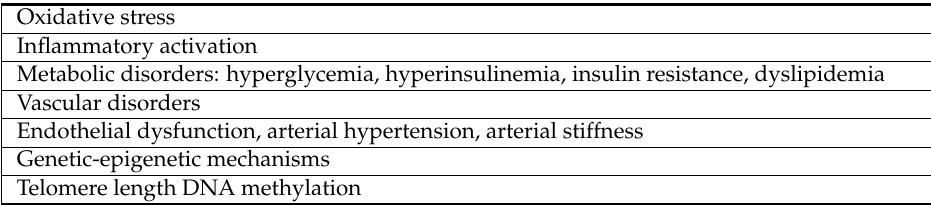
Table 1. Pathophysiological mechanisms affecting cardiovascular